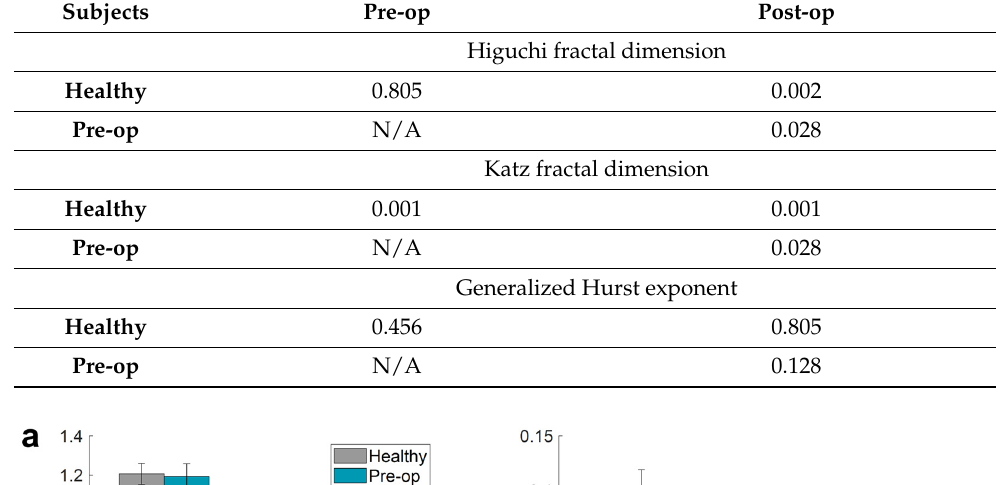
Table 6. p -values for the comparison of corneal elevation-derived curvature measures obtained Table 6. p ‐ values for the comparison of corneal elevation ‐ derived curvature measures obtained from Pentacam. from Pentacam.